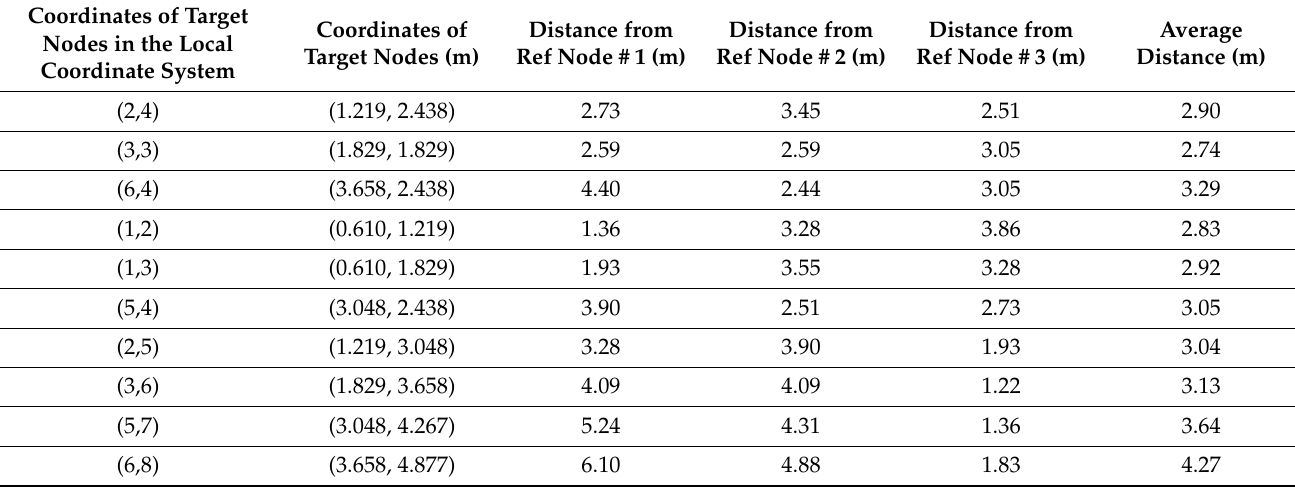
Table 5. Coordinates and distances of target